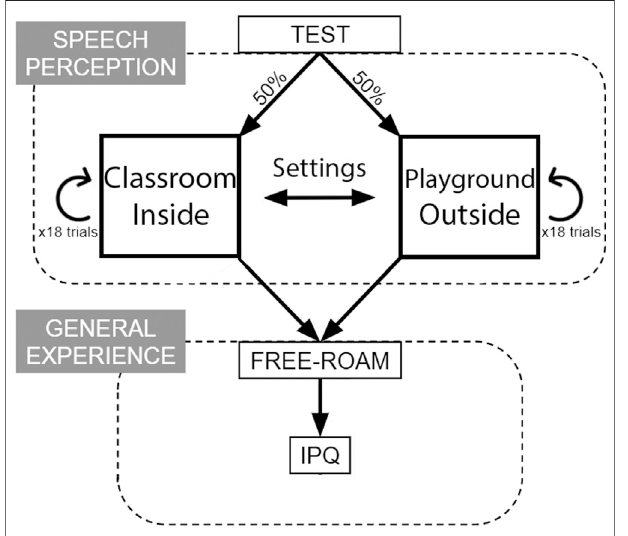
FIGURE 7 | An illustration of the experimental design procedure.